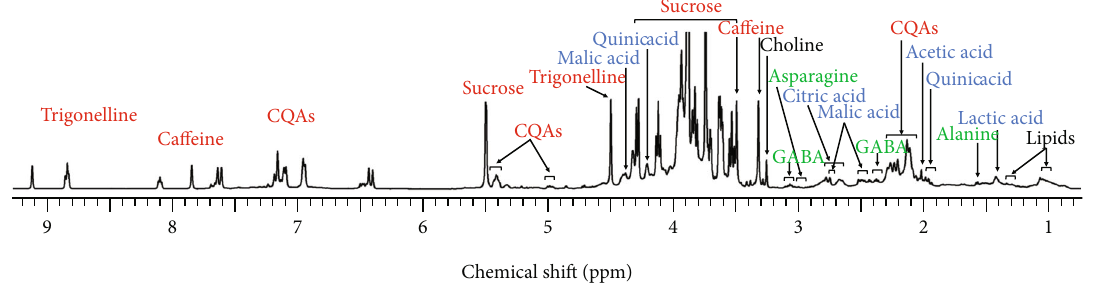
Figure 1: Signal assignments of the identi fi ed metabolites in the 1 H NMR spectrum of the green co ff ee